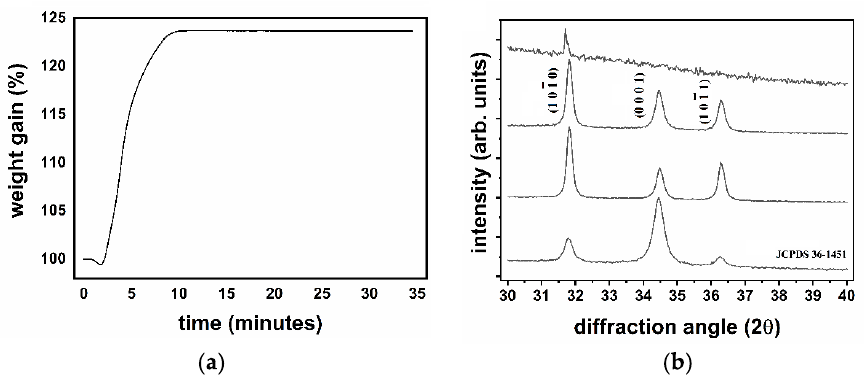
Figure 1. ( a ) Isothermal TGA analysis of metallic Zn at 500 ◦ C; ( b ) XRD results: changes in the position and breadth of the main Bragg peak indicate a tuning of the on-axis preferential crystallographic orientation, as well as of the average size of the ZnO